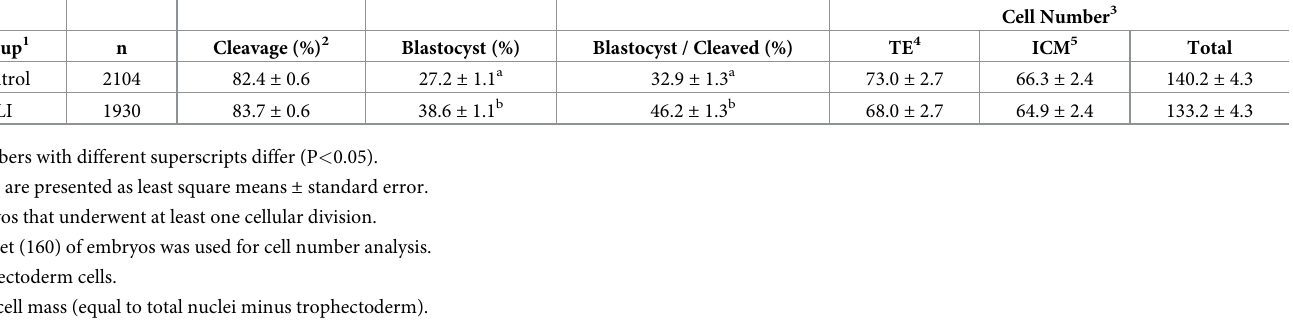
Table 3. In vitro development and number of nuclei in bovine embryos supplemented with and without FLI in